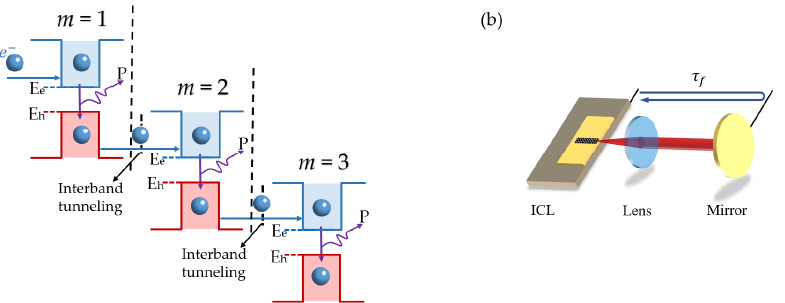
Figure 1. ( a ) 3-stage number structure of interband cascade laser(ICL); ( b ) Schematic diagram of ICL with optical feedback structure.